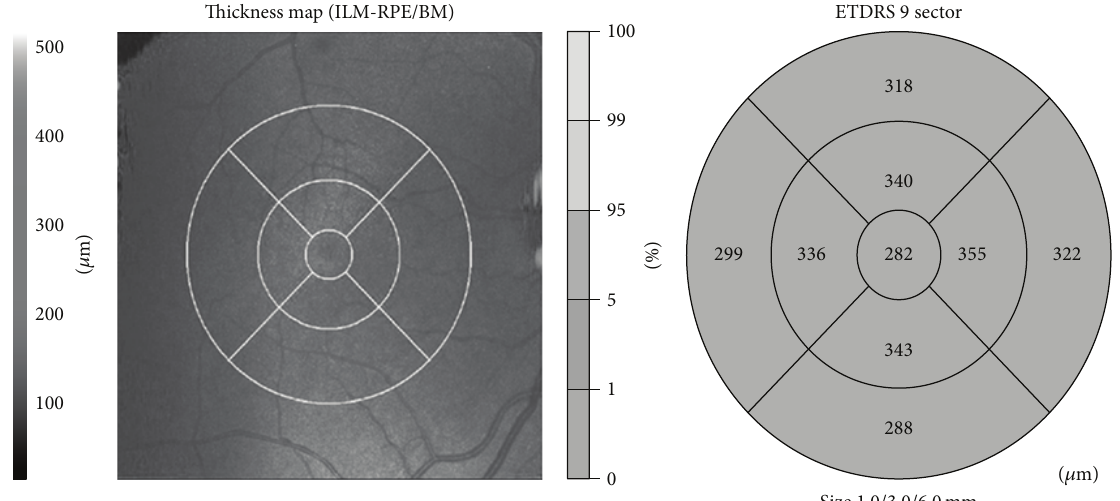
Figure 1: Macular thickness map diagram and ETDRS